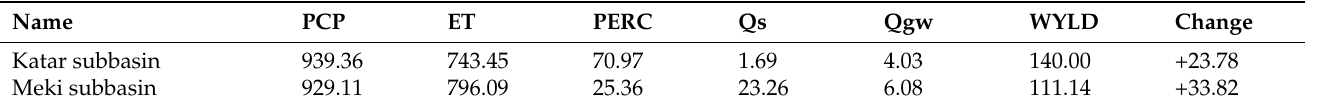
Figure 8. Temporal variation of water balance (mm) components in Katar ( a ) and Meki ( b ) from 1999 to 2014. Table 7. Average annual water balance components of Katar and Meki subbasin